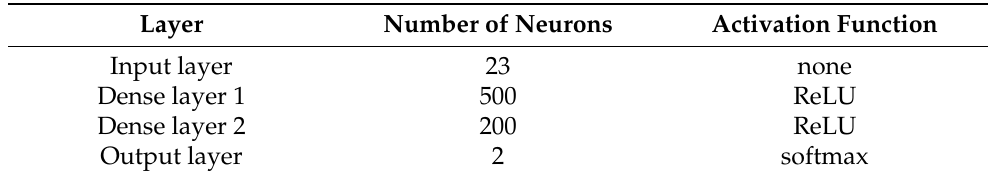
Table 3. Architecture of the fully connected neural network which is used to deploy Layer-wise Relevance